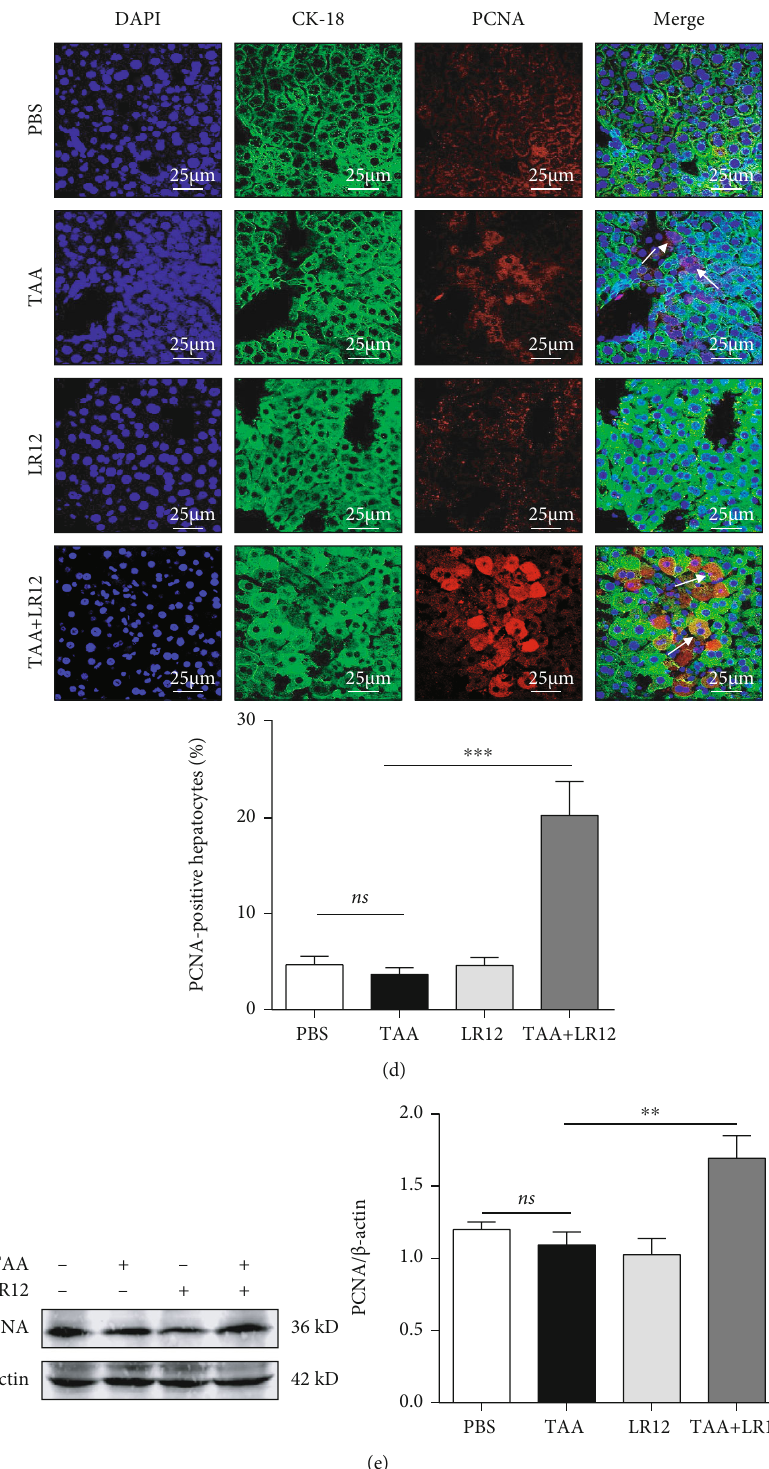
Figure 1: Injection of LR12 reduced the liver in fl ammation and stimulated liver regeneration following TAA-induced ALF in mice. (a) H&E staining (magni fi cation, 200x and 400x) showing in fl ammatory cell in fi ltration and necrotic area (%) in the liver. (b) Serum levels of alanine aminotransferase (ALT) and aspartate aminotransferase (AST). (c) Survival curve from mice with TAA-induced ALF ( n = 9 /group). (d) CLSM showing CK18 and PCNA staining in the liver. (e) Western blotting detected PCNA expression in the liver tissue. Data were presented as the mean ± standard deviation (SD) ( n = 6 ). ∗ P < 0 : 05 , ∗∗ P < 0 : 01 , and ∗∗∗ P < 0 : 001 versus control